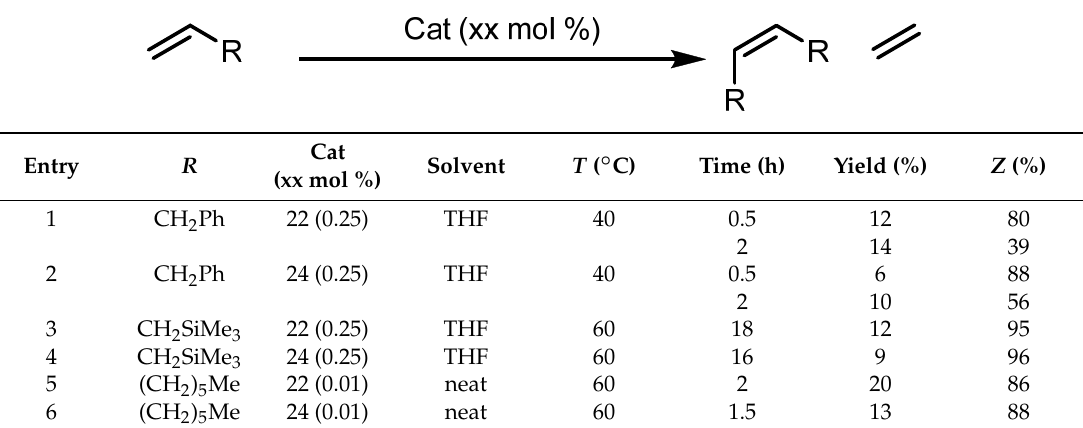
Figure 6. Model of 22 ’s mode of selectivity by shielding one side of the ruthenacycle. Table 9. Homodimerization of olefins employing 22 and 24 . Table 9. Homodimerization of olefins employing 22 and 24 .